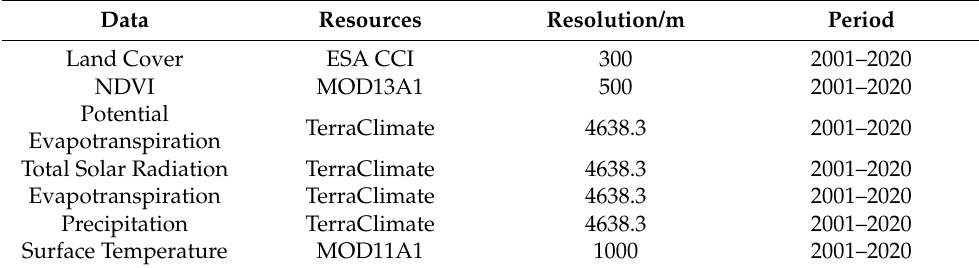
Table 1. Data sources and basic characteristics.